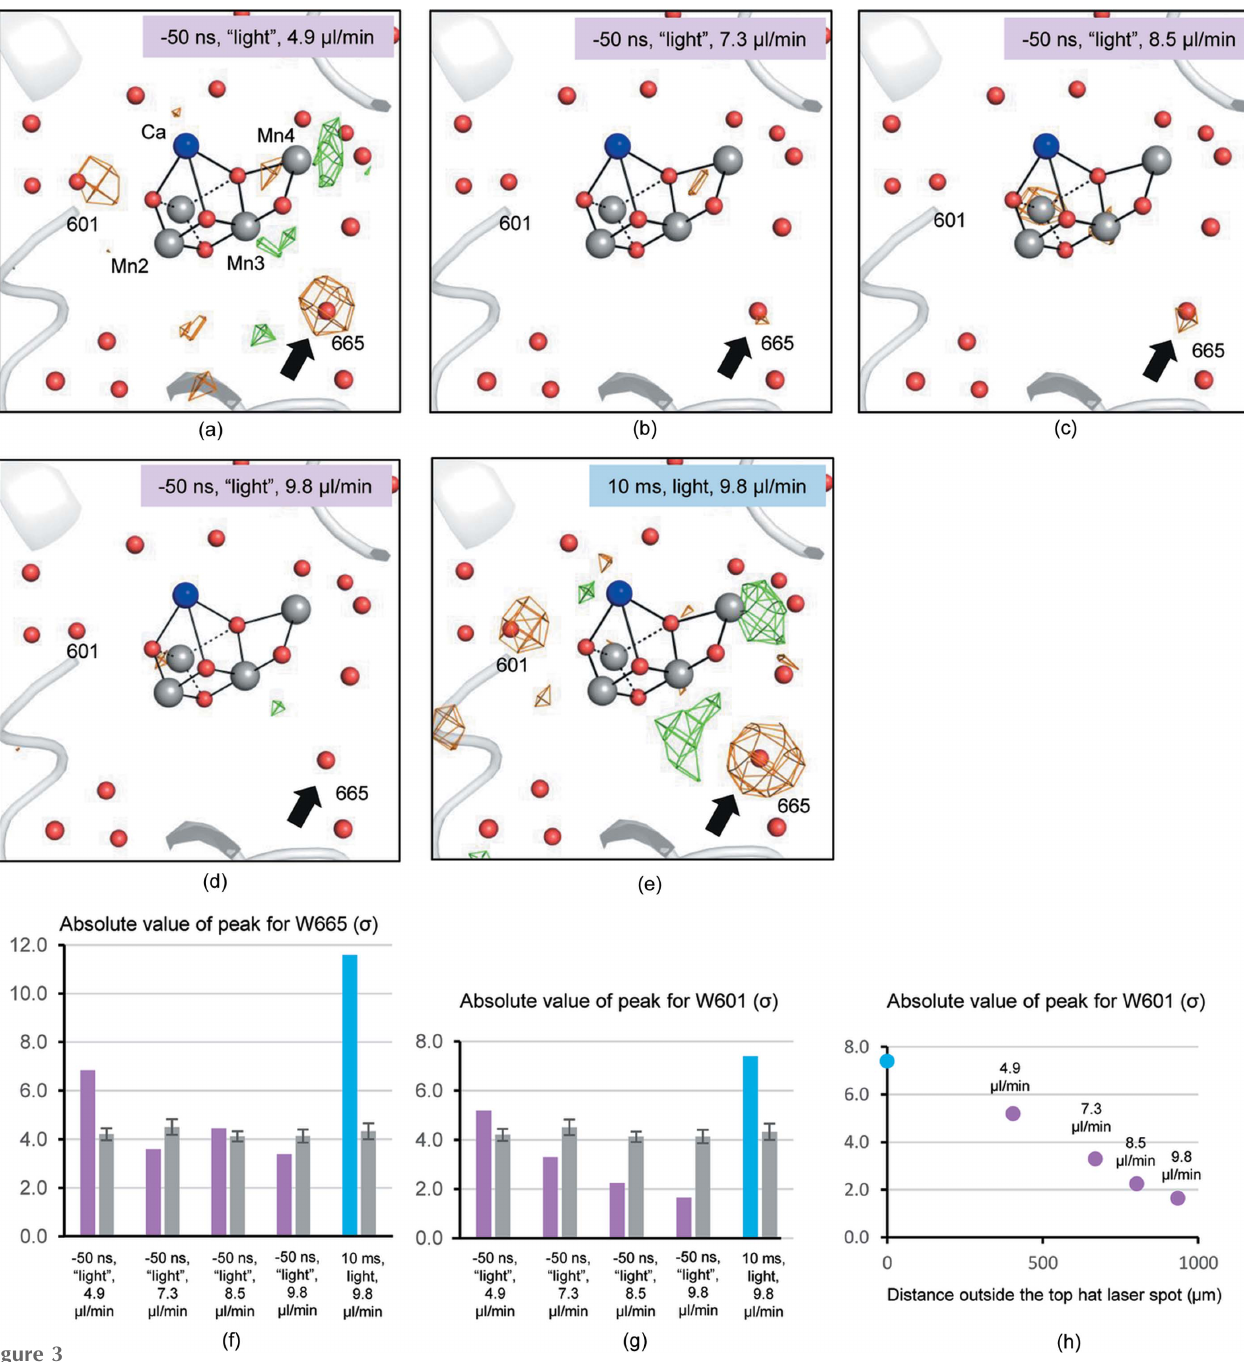
Table S1], and reached a level not visible in the difference map which is also well below the maximum noise level